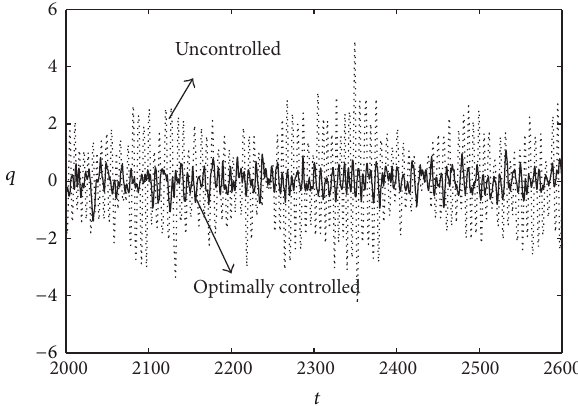
Figure 4: The sample time history of displacement of uncontrolled and optimally controlled system